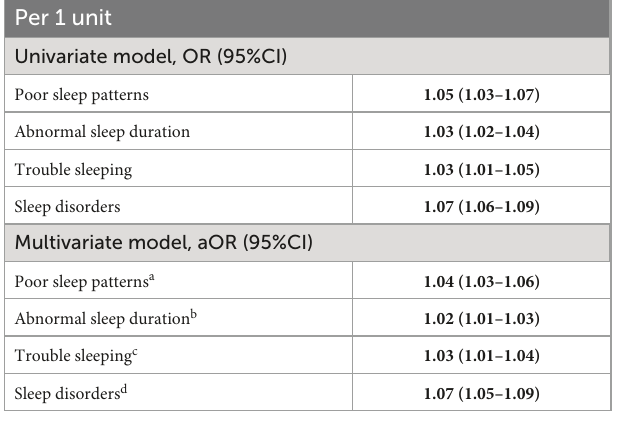
TABLE 4 Associations between BMI, poor sleep patterns and its